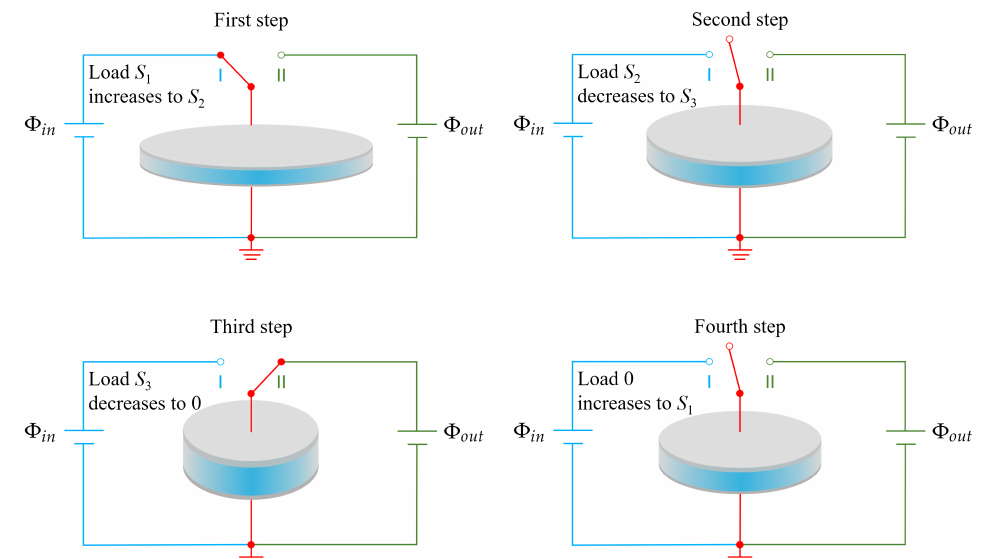
Figure 2. Schematic of the performance of a soft energy harvester that is able to pump electric charges from low voltage ( Φ in ) to high voltage ( Φ out ) by using a